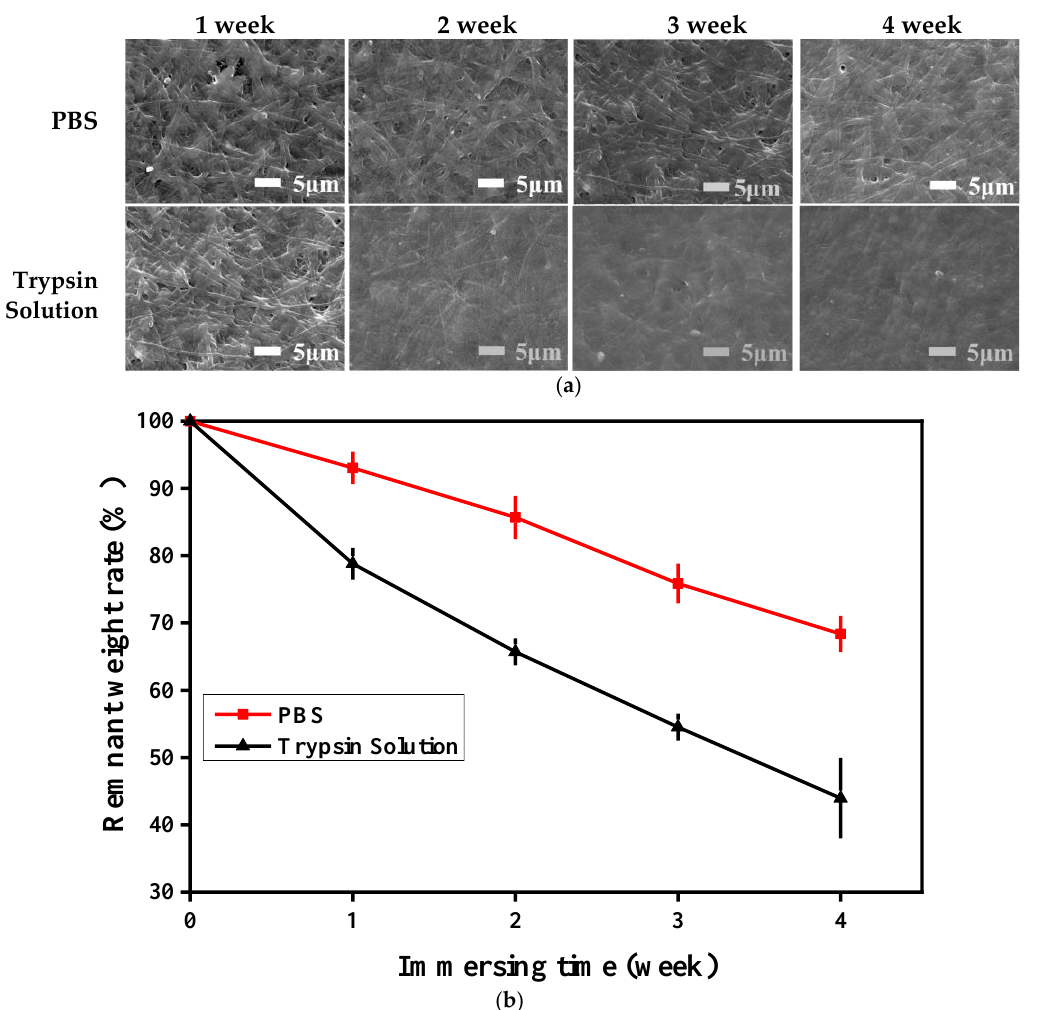
Figure 6. SEM images and weight loss rates of the γ -PGA/keratin ENS immersed in PBS solution and trypsin solution for different times: ( a ) SEM images; ( b ) weight loss rates.